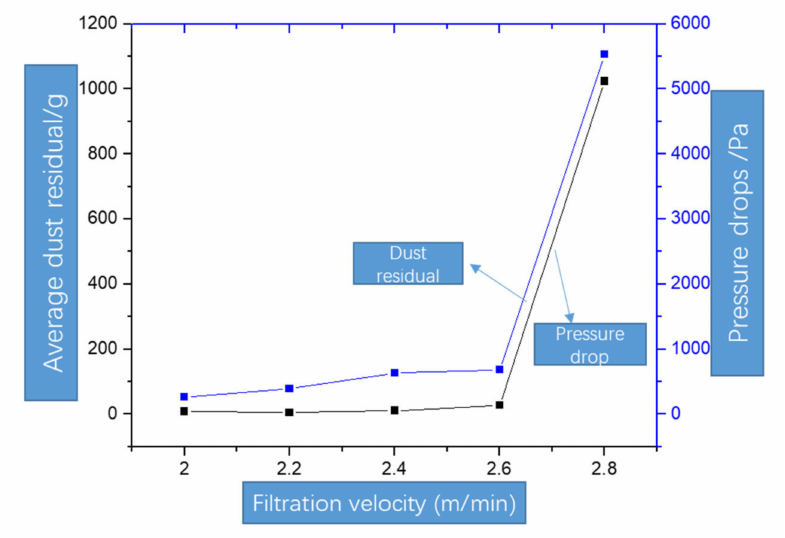
Figure 13. The residual dust and pressure drops vary with filtration velocity during the filtration and cleaning process for the purification of the dust-laden airflow.